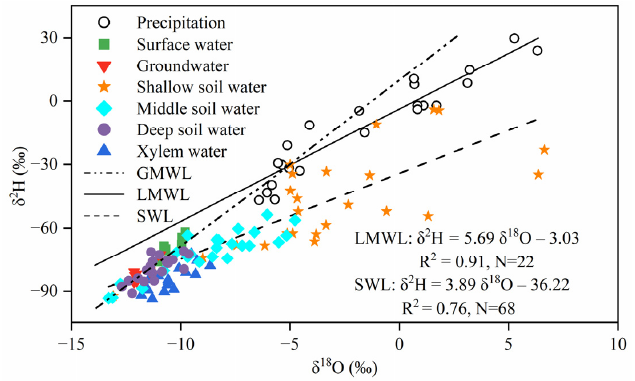
Figure 3. Cross plots of δ 18 O vs. δ 2 H for the precipitation, soil water, surface water, groundwater, and plant water samples. The regression lines of soil water (SWLs) and precipitation (LMWLs) and their relationship with the global meteoric water line (GMWL) are also shown in the